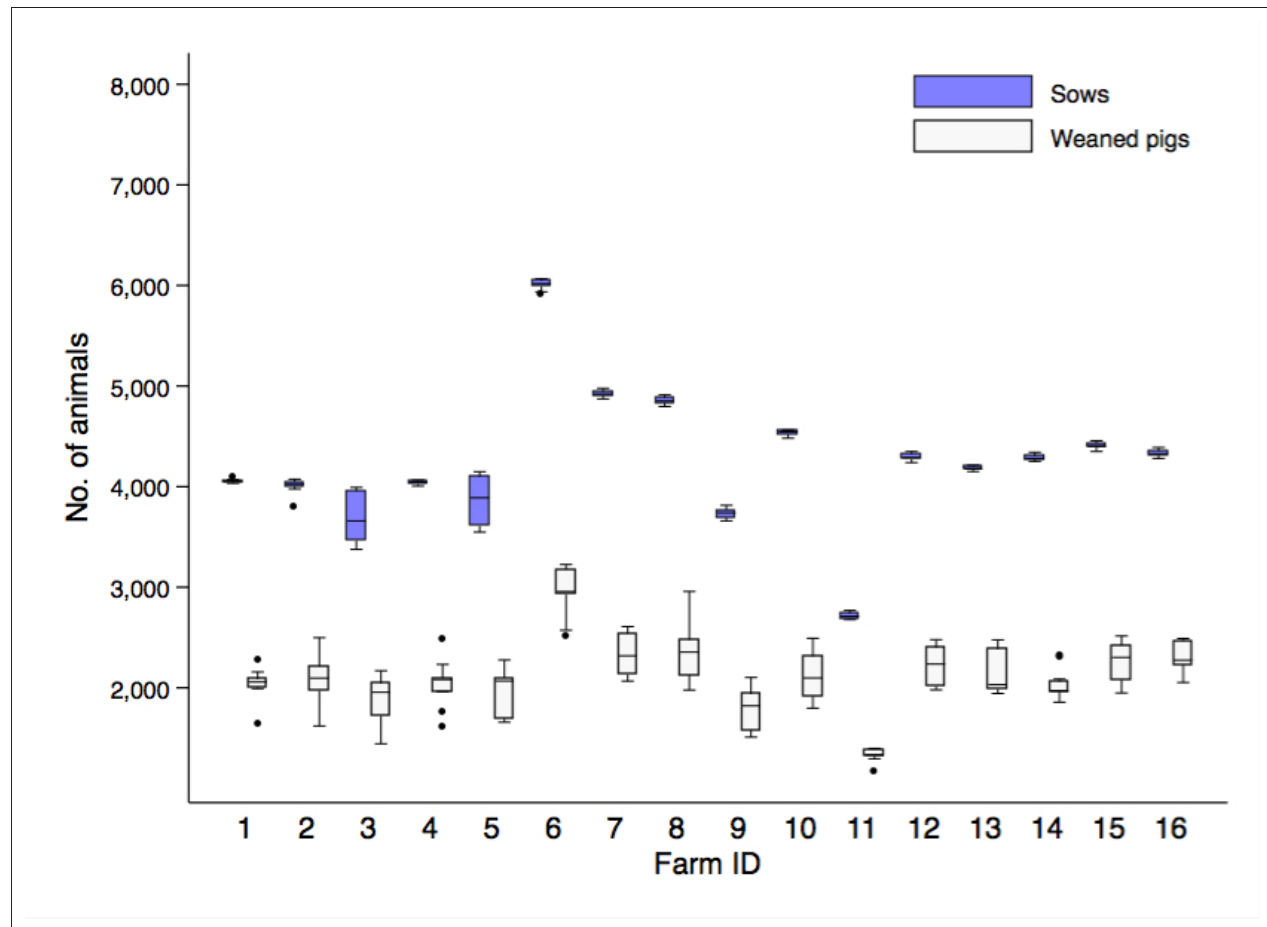
FigUre 1 | Number of sows and weaned pigs in sixteen farms affected by porcine reproductive and respiratory syndrome (PRRS) through the pre-outbreak period. Boxes indicate the first and third percentile and middle bars represent the